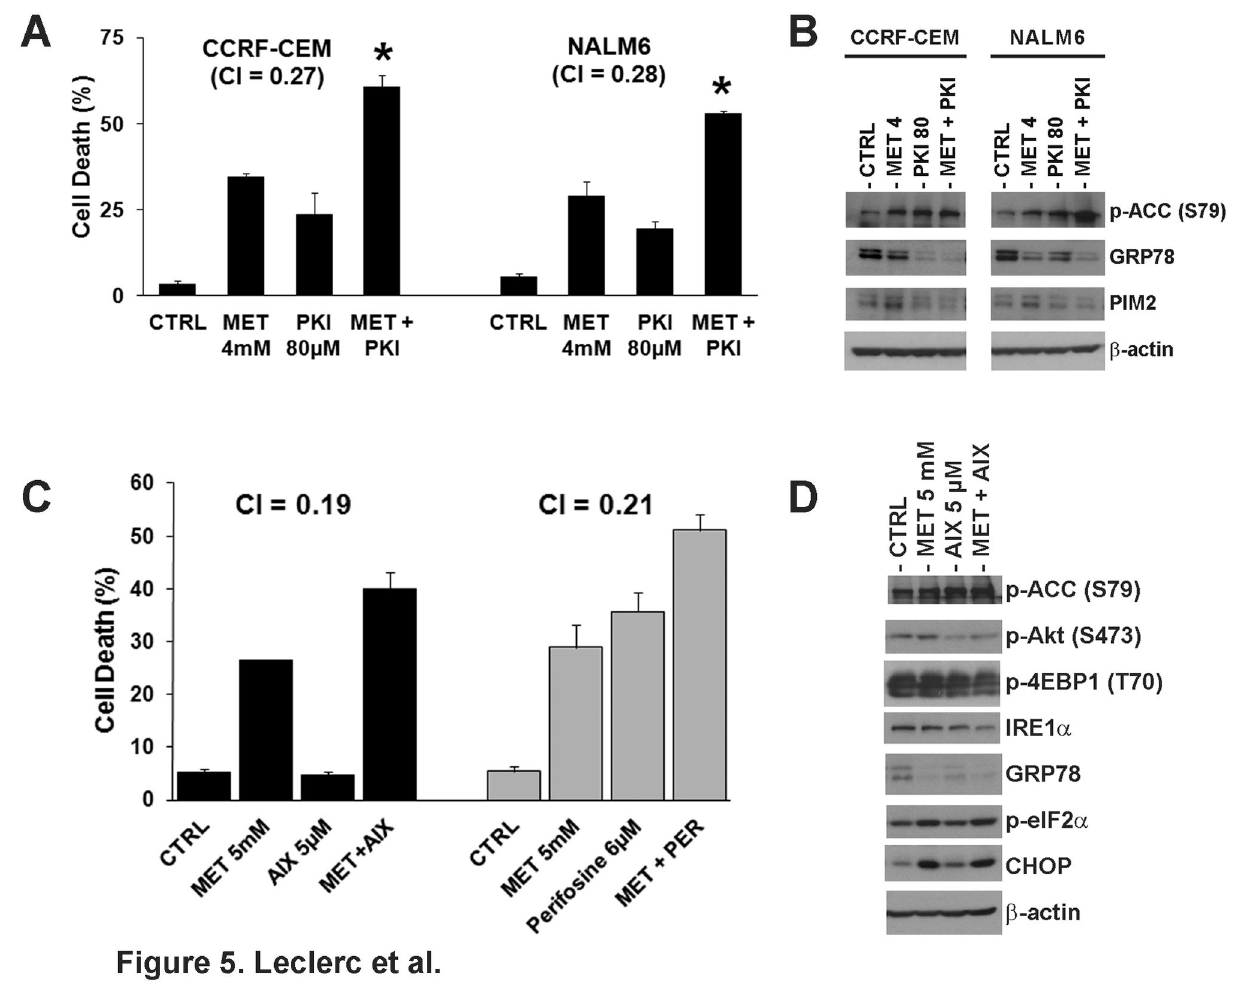
Figure 5. Inhibition of PIM-2 and Akt kinases synergistically sensitizes ALL cells to metformin. A ) Cell death in CCRF-CEM and NALM6 cells treated with metformin (MET, 4 mM) and the PIM-1/2 kinase inhibitor V (PKI; 80 µM), either alone or in combination for 72 h at 37°C. The CI values of 0.27 and 0.28 indicate synergism. B ) Immunoblotting of p-ACC (S79), GRP78, and PIM-2 expression in the CCRF-CEM and NALM6 cells treated with MET plus PKI described in ( A ). C ) Cell death in NALM6 cells treated with metformin (MET, 5.0 mM) and Akt inhibitor X (AIX; 5 µM) or perifosine (PER; 6 µM), either alone or in combination for 72 h at 37°C. CI values of 0.19 (MET + AIX) and 0.21 (MET + PER) indicate synergism. The cell death values were expressed as a percentage (%) of cells in the population (mean ±SEM, n = 3). D ) Immunoblotting of AMPK/ACC, Akt/mTOR, and UPR signaling pathway proteins in the NALM6 cells treated with MET (5.0 mM) plus AIX (5 µM) described in ( C ).